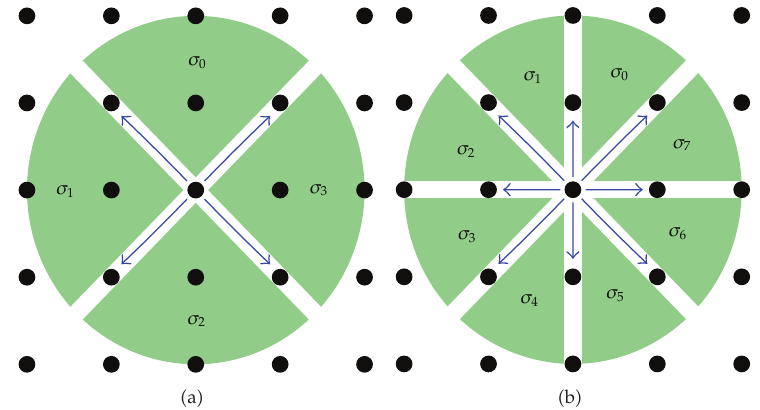
(cid:16) S (cid:2) b (cid:3)